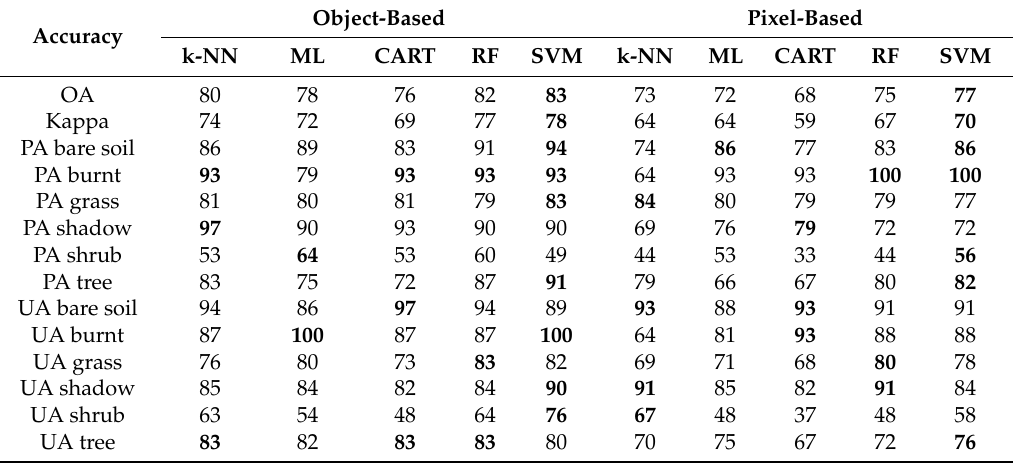
Table 5. Accuracy indices (%) for all five pixel- and object-based classifiers for July 2012. Bold values represent the maximum value. OA = Overall Accuracy; PA = Producer Accuracy; UA = User Accuracy.